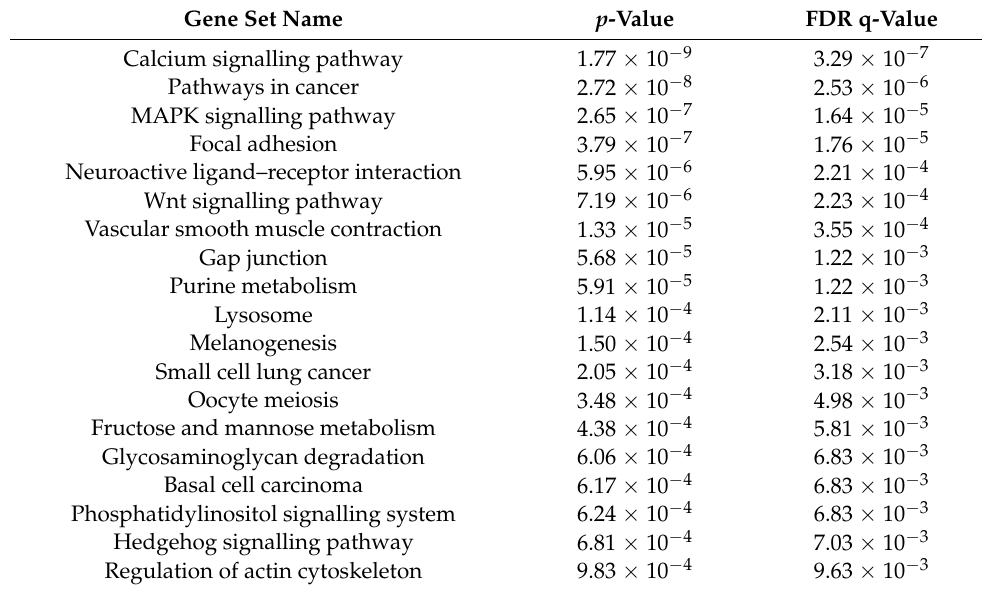
Table 3. The enriched pathways of important genes in BC (FDR q-value < 0.01). Gene Set